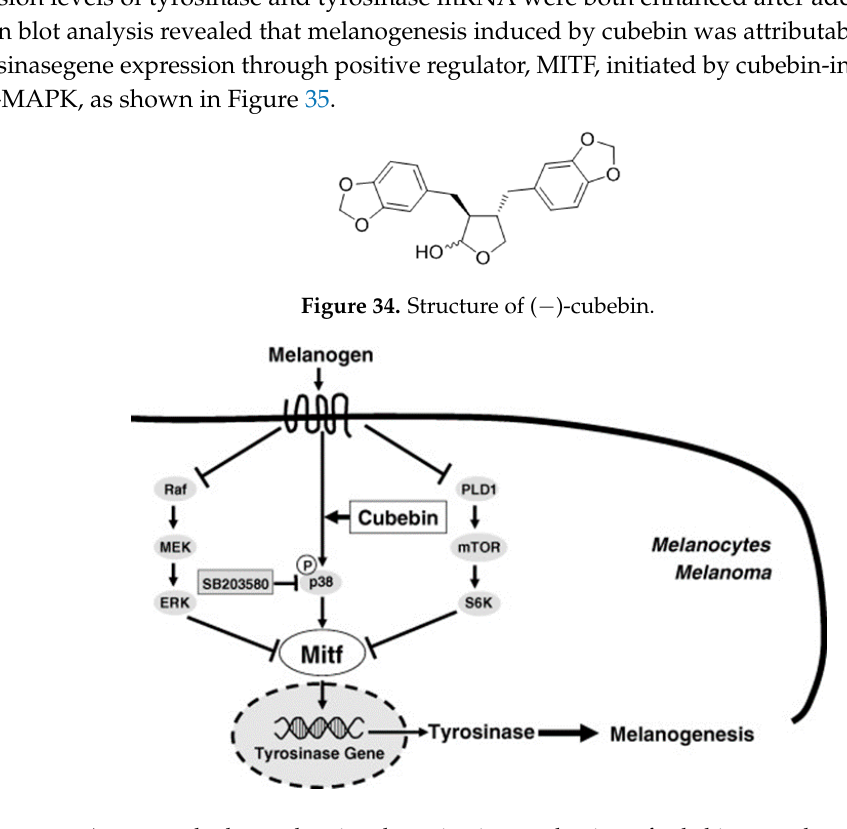
Figure 35. A proposed scheme showing the activation mechanism of cubebin on melanogenesis [107].